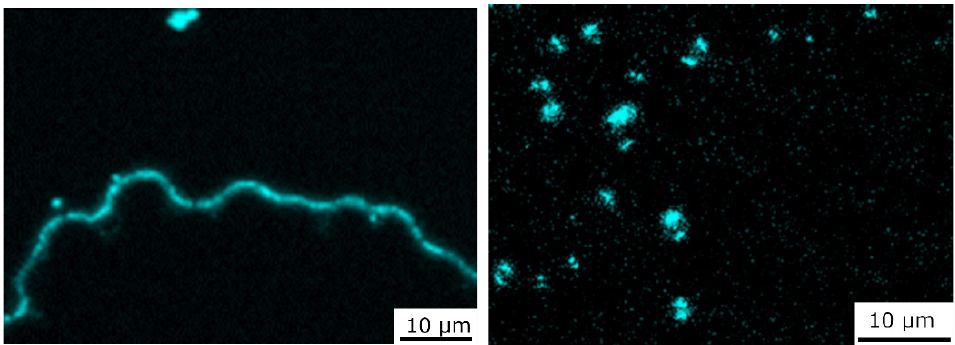
Figure 5. Microstructure of the Mg1.8Y/T300 ( left ) and Mg1.8Y/Granoc ( right ) composites.